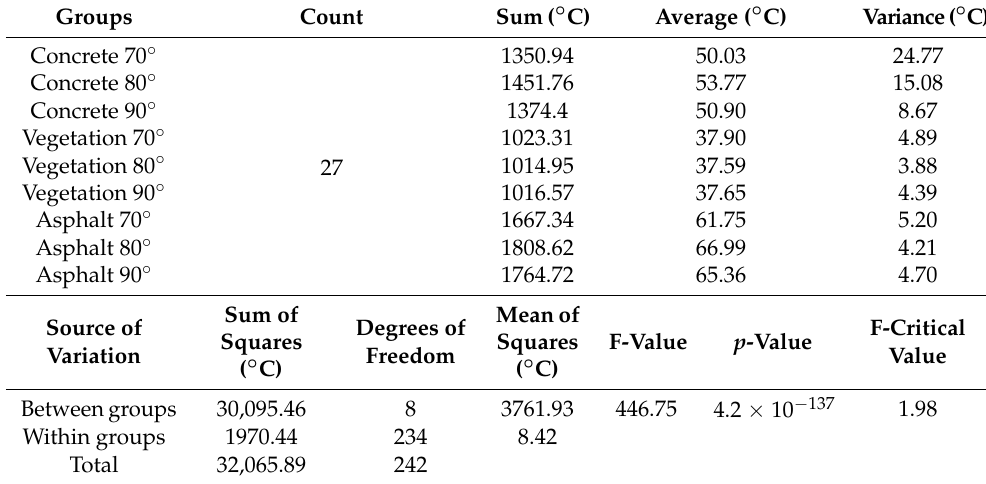
Table 7. ANOVA test to compare the difference in LST for each land cover according to the angle in study area